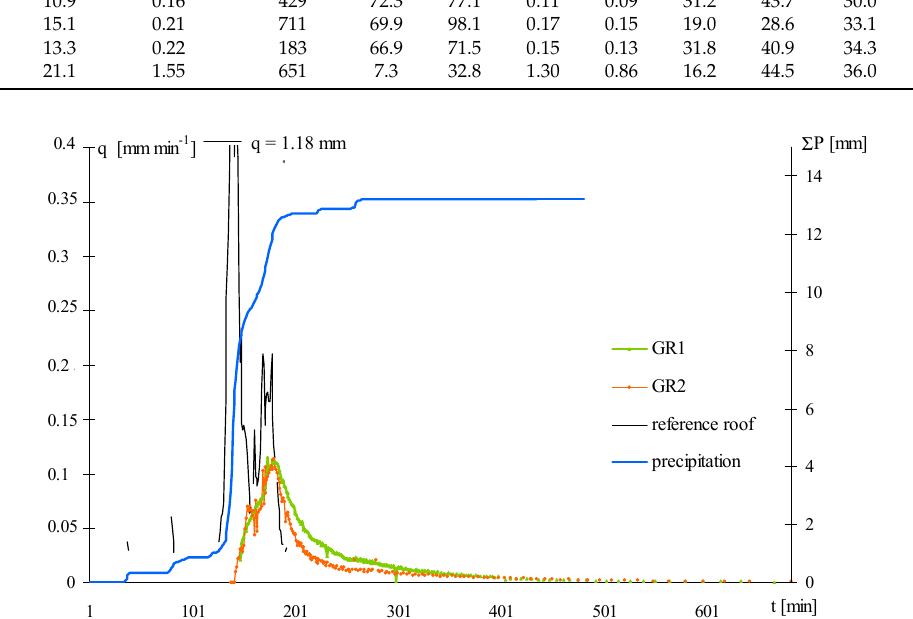
Figure 2. Hydrograph and accumulated rainfall for a storm on the green roof surface with a vegetation layer based on zeolite (GR1) and pumice (GR2) with reference to the control surface in 28 July 2017.